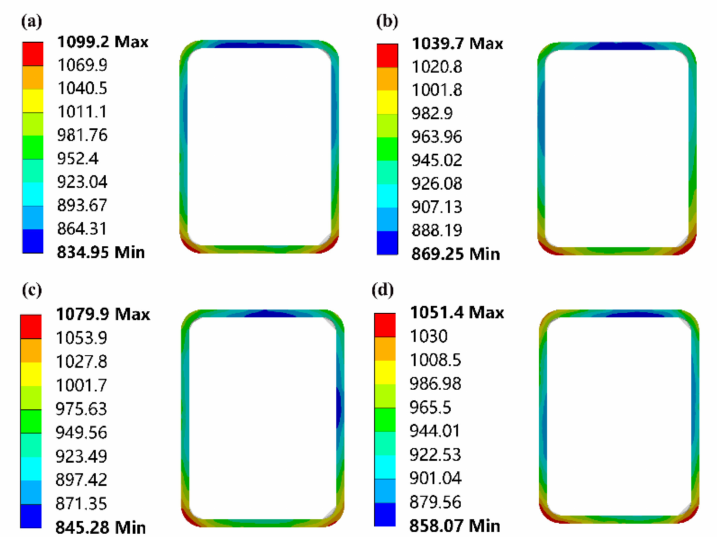
Figure 13. The temperature distribution of a rectangular steel tube with different inductor widths: ( a ) 5 mm; ( b ) 10 mm; ( c ) 15 mm; ( d ) 20